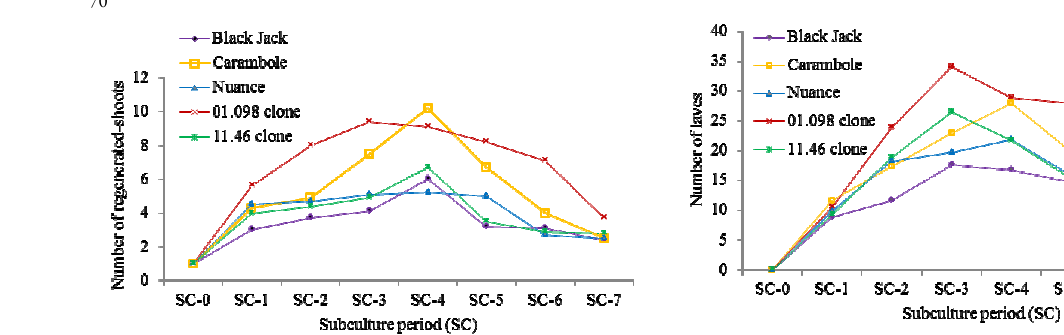
Fig. 5. Number of leaves derived from different responses of Gerbera varieties-clones under periodical subculture every 1.5 months